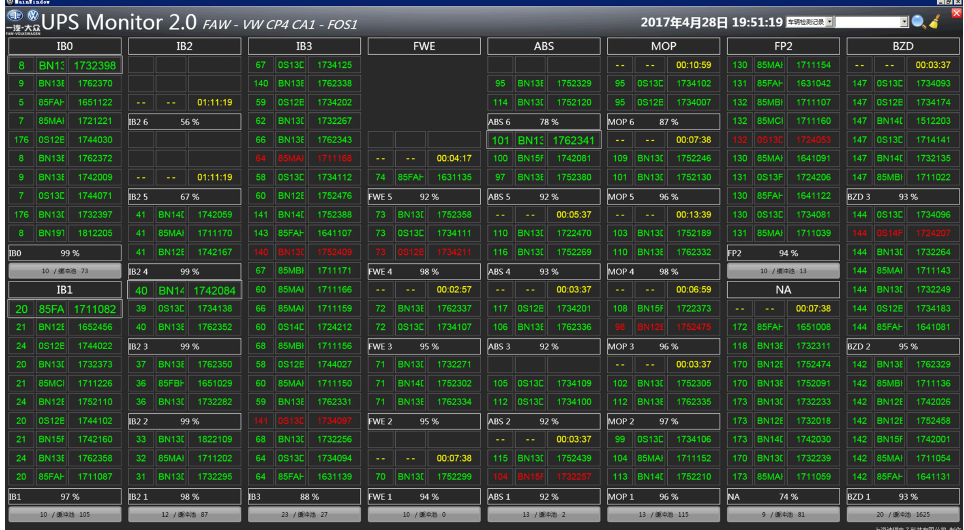
Figure 16. UPS (Uninterruptible Power Supply) monitoring system.